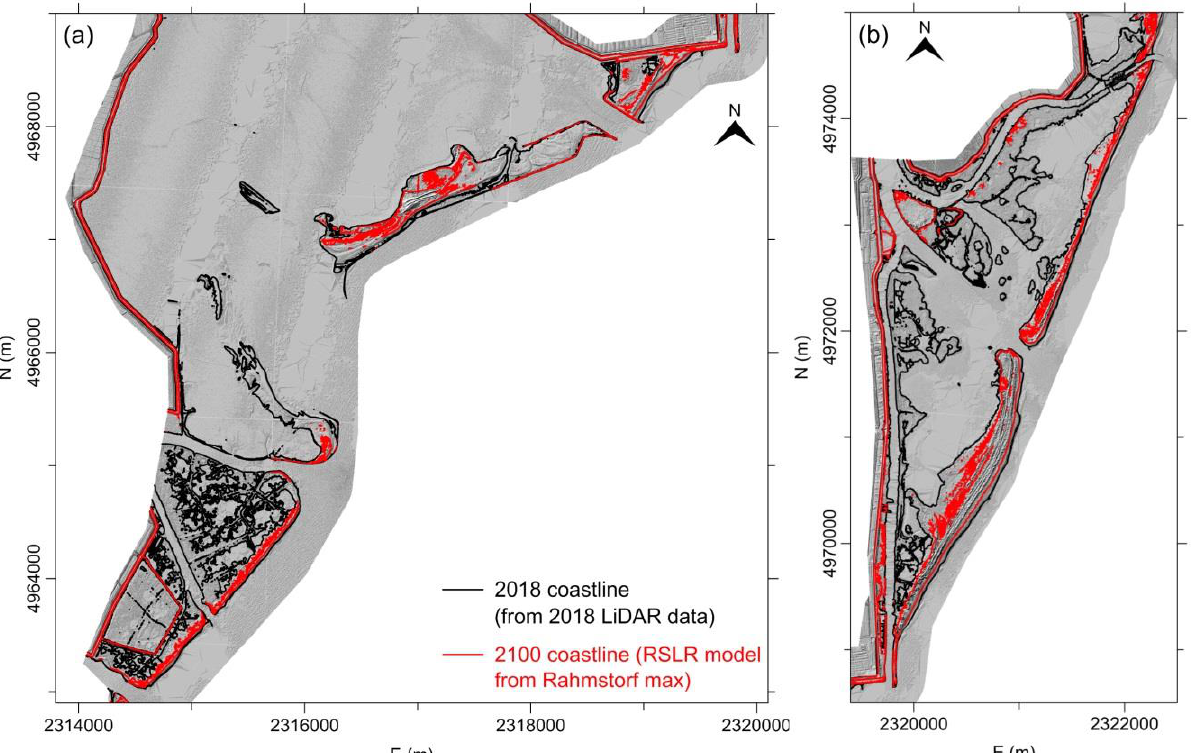
Figure 13. Coastlines representation from the 2018 LiDAR DTM (corrected 0 m contour line level, in black) and with the application of the RSLR projection in 2100 from the [51] max model (1395 mm, in red) for the most critical sub-areas 2 (Sacca degli Scardovari, ( a )) and 3 (Bacino Bonelli Levante, ( b )) in the PRD coastal area.